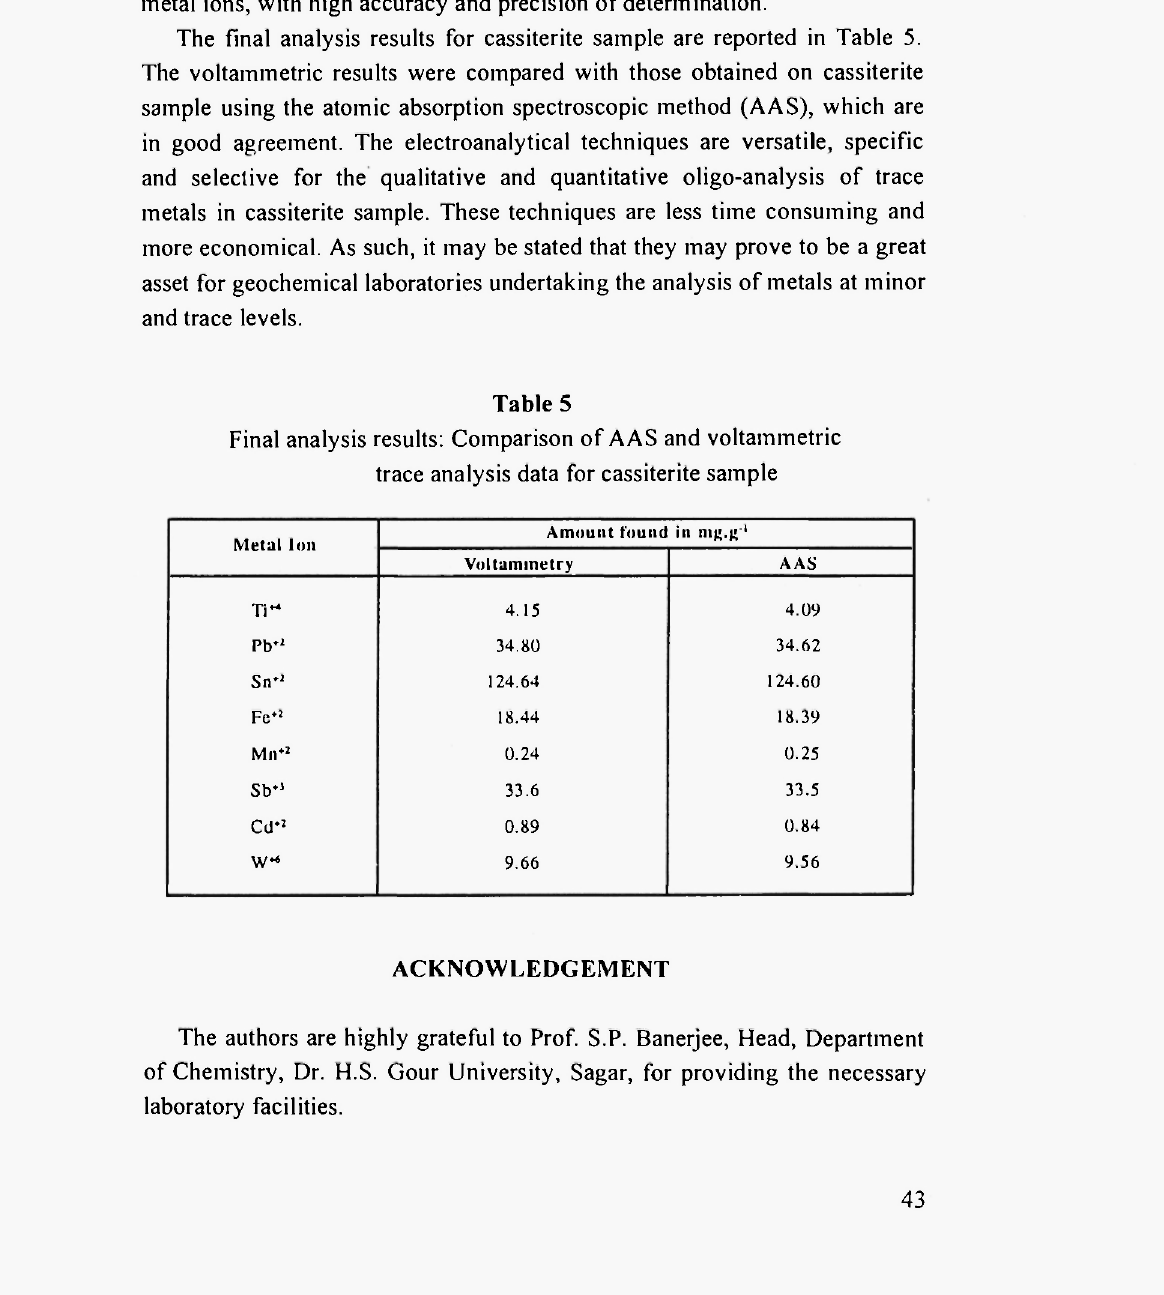
Final analysis results: Comparison of AAS and voltammetric trace analysis data for cassiterite